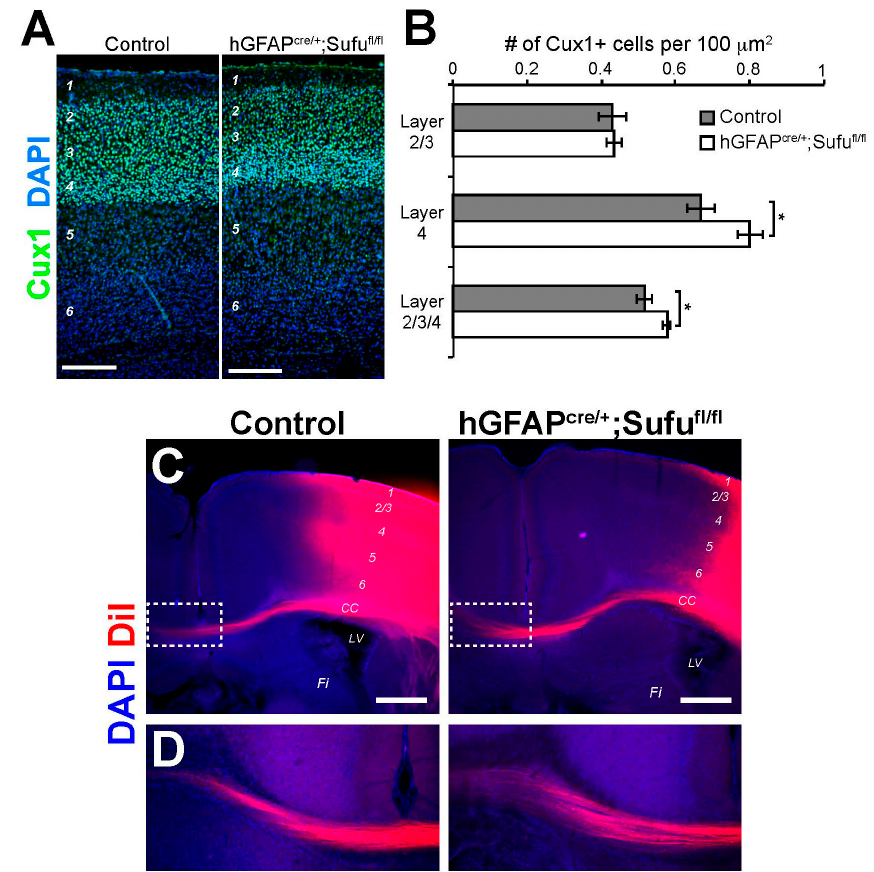
Figure 8. Mild increase in Cux1+ projection neurons and normal callosal projections in the postnatal hGFAP cre/+ ;Sufu fl/fl neocortex. ( A , B ) Cux1 immunolabeling of upper layer projection neurons showed a comparable distribution of Cux1+ neurons, with a densely packed layer 4, in the P7 hGFAP cre/+ ;Sufu fl/fl neocortex ( A ); Quantification of Cux1+ projection neurons ( B ) yielded comparable densities of Cux1+ neurons in Layer 2/3 between control and hGFAP cre/+ ;Sufu fl/fl neocortex. A borderline increase in the density of Cux1+ neurons were quantified in layers 2–4 of the P7 hGFAP cre/+ ;Sufu fl/fl neocortex ( p -value = 0.054) and appears to be due to a mild increase in the density of Cux1+ neurons in layer 4 ( p -value = 0.058). Scale bars = 200 μ m. CC, corpus callosum; LV, lateral ventricles; FI, fimbria; ( C , D ) DiI tracing showed that callosal projections that originate from upper cortical layers were grossly unaffected in the P15 hGFAP cre/+ ;Sufu fl/fl neocortex and is comparable with control littermates ( C ); Callosal projections were able to project across the midline into the contralateral hemisphere (boxed, D ); Scale bars = 500 μ m. DiI, 1,1 ′ -dioctadecyl-3,3,3 ′ ,3 ′ -tetramethylindocarbocyanine.